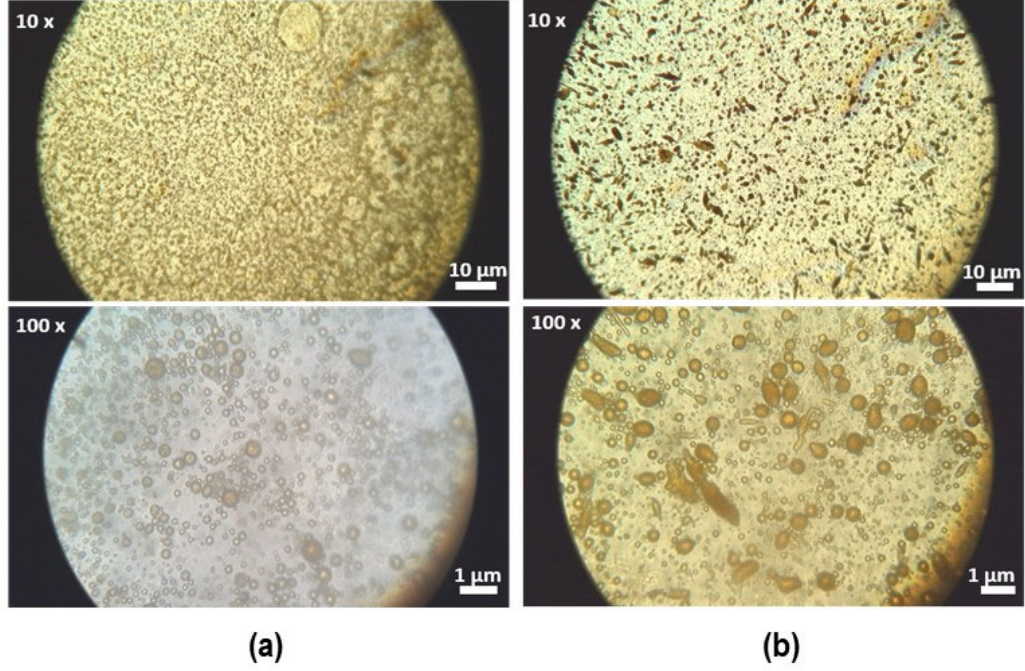
Figure 7. Microphotographs of Bacillus licheniformis ( a ) and Pseudomonas putida ( b ) from the bioreactors at 10X and 100X. Crude oil dispersions promoted by extracellular biosurfactants can be observed in 100X microphotographs.